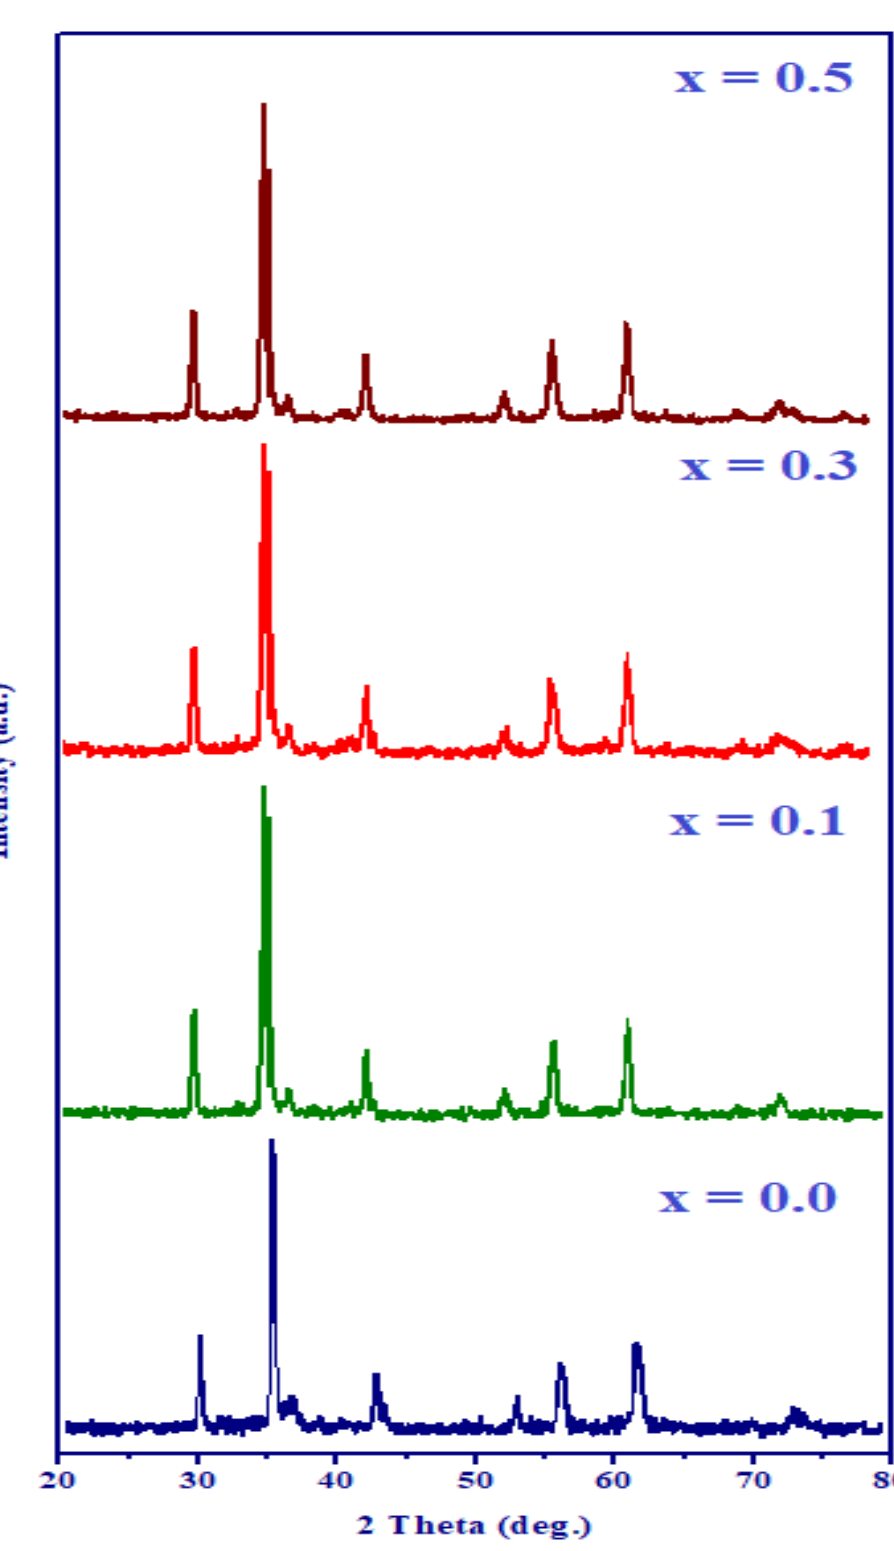
Figure 1. Powder XRD pattern of spinel MnCe x Fe 2 − x O 4 (x = 0.0, 0.1, 0.3 and 0.5)